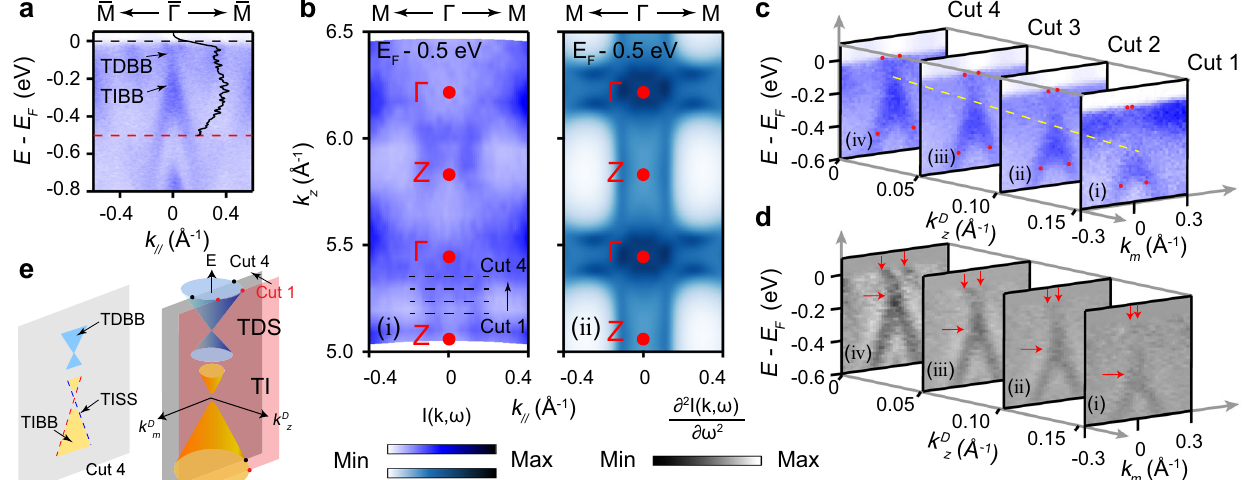
Fig. 2 Dual topological bulk bands. a Intensity plot along Γ - M direction with p -polarized 100 eV photons. Two bulk band (marked as TDBB and TIBB) near Γ point are dominated. b Intensity plot of k z dependent ARPES data (i) and corresponding bulk calculated result (ii) along Γ - M direction with p -polarized photons at E F - 0.5 eV, which indicate the k z dispersion of TIBB. c ARPES intensity plot along Γ - M direction at different k z indicated by black dashed lines marked as Cut 1 to 4 in ( b ) with h ν = 94, 96, 98 and 100 eV p -polarized photons. d Second derivative plot of ( c ). e Schematic of projected two Dirac cone from TDS and TI into the ( k m , k z , E) space.